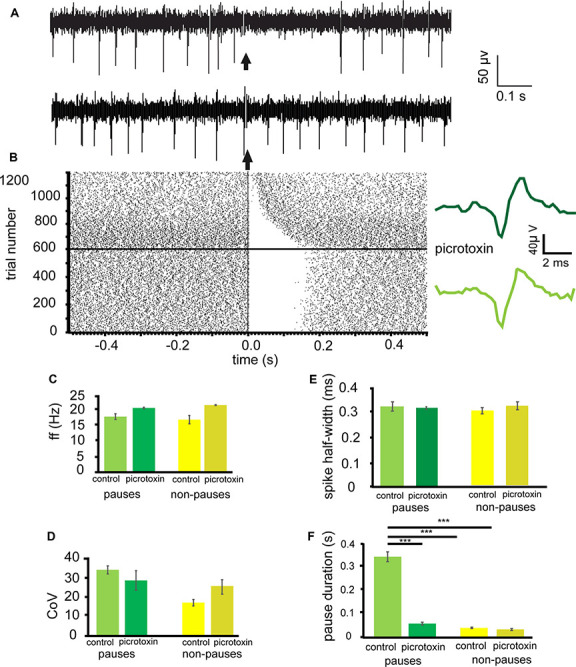
Picrotoxinsubstantially disinhibits VP neurons inhibited by NAc stimulation. All experiments presented in this figure used the first stimulation protocol (one stimulation of 200 μs duration followed by a 10-s gap) identified in the “Materials and Methods” section.  (A) A typical example of a raw data trace from a neuron in the VP with a pause in tonic activity after stimulation of the NAc and a raw trace from the same neuron after the application of picrotoxin with no pause in tonic activity. (B) A typical example raster plot of tonic firing activity in a VP neuron from 0.5 s pre-stimulation to 0.5 s post-stimulation of the NAc. The raster plot exemplifies one neuron response during 600 applications of stimulation in control conditions and 600 stimulations after the application of picrotoxin. To the right of the raster plot are two representative traces, the light green being before the application of picrotoxin and the dark green being after the application of picrotoxin. (C) Bar chart representing the no-significant difference in baseline firing frequency (Hz) for neurons that pause and those that did not pause in response to NAc stimulation, in control conditions and in the presence of picrotoxin. (D) Bar chart representing no-significant differences in baseline coefficient of variation for neurons that pause and those that did not pause in response to NAc stimulation, in control conditions, and in the presence of picrotoxin. (E) Bar chart representing no-significant differences in spike half-width for neurons that pause and those that did not pause in response to NAc stimulation, in control conditions, and in the presence of picrotoxin. (F) Bar chart representing significant differences (***P < 0.001) in pause duration for those neurons that paused in response to NAc stimulation (green) compared to the same neurons in the presence of picrotoxin, and compared to those neurons that did not pause in response to stimulation (yellow) in control conditions and in the presence of picrotoxin.